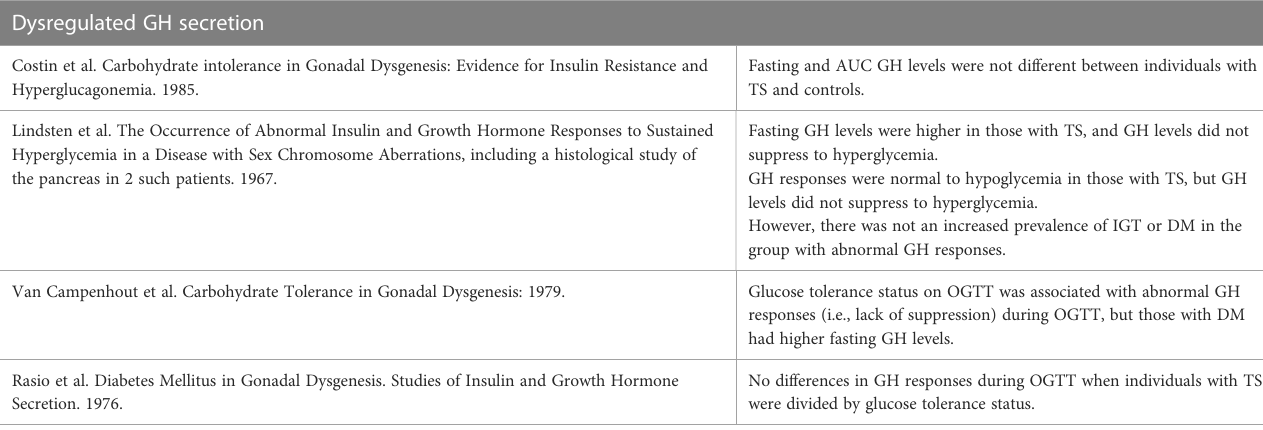
TABLE 2 Summary of key studies evaluating growth hormone secretion in TS and its potential relationship to the TS-associated hyperglycemia phenotype. Dysregulated GH secretion Costin et al. Carbohydrate intolerance in Gonadal Dysgenesis: Evidence for Insulin Resistance and Hyperglucagonemia. 1985.